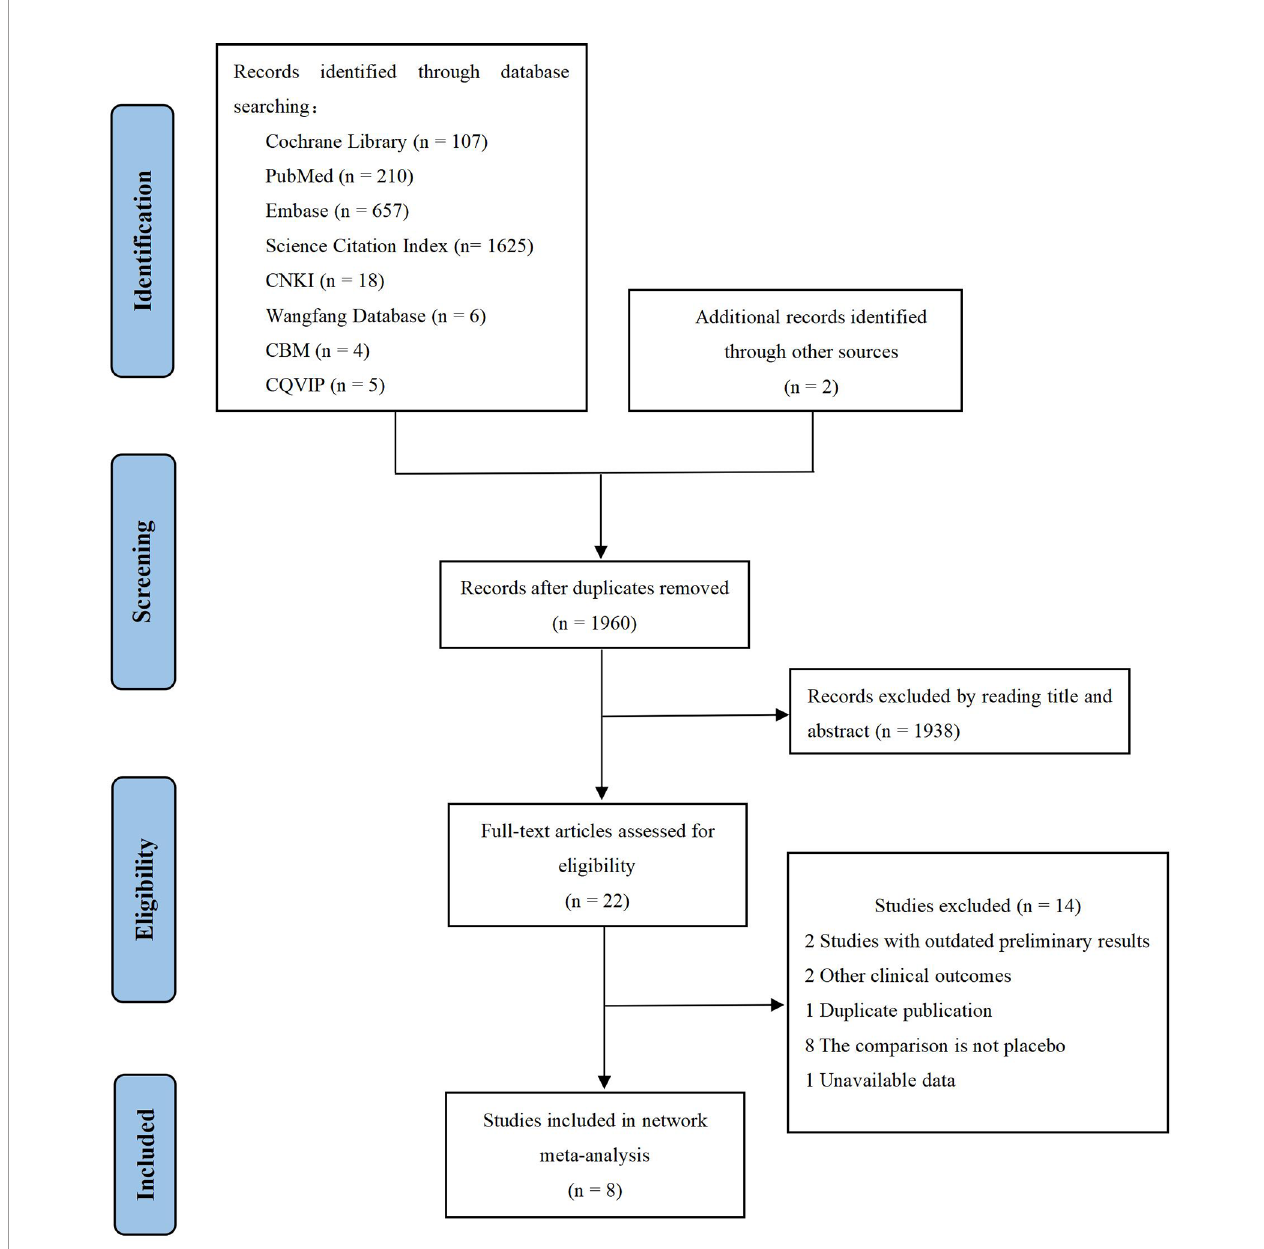
FIGURE 1 | Flow diagram of study